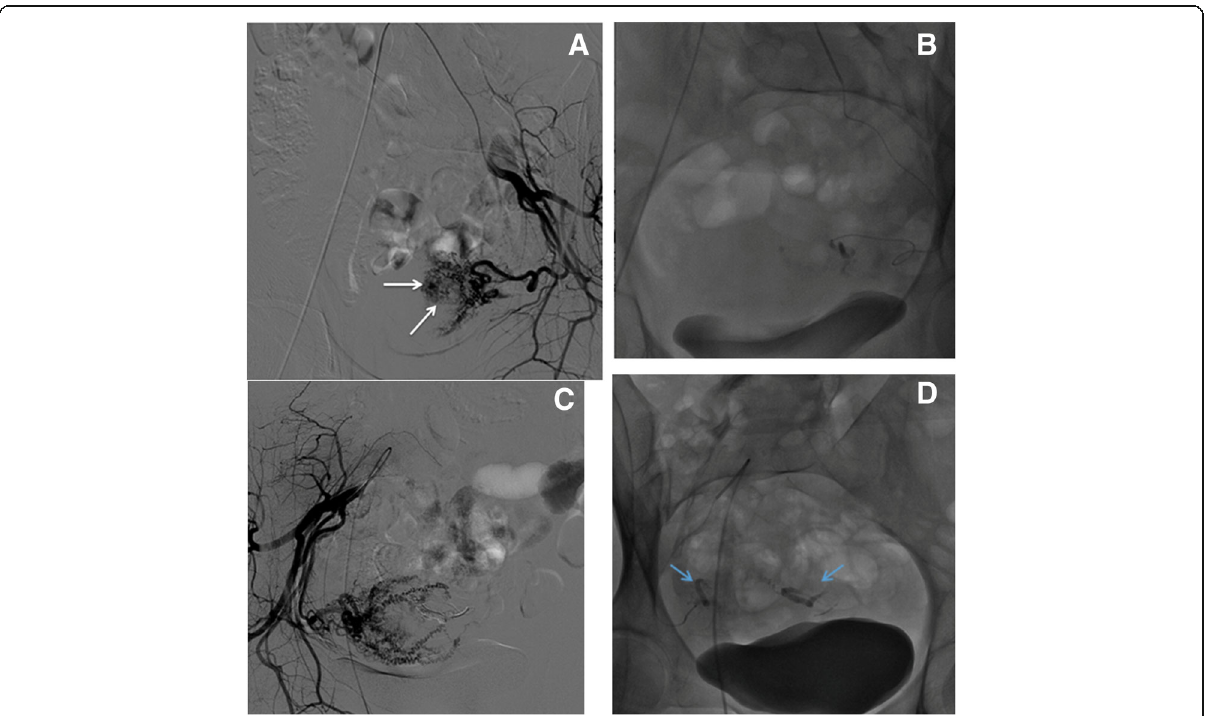
Fig. 3 Arteriovenous Malformation (AVM) embolization . a Right transfemoral DSA of the left hypogastric artery shows an uterine AVM (white arrows). b A superselective embolization with microcatheter of the left uterine artery is performed using PVA particles and Squid-18. c Diagnostic DSA of the right hypogastric artery. d After bilateral uterine AVM embolization, X-rays show both uterine arteries opacified with Squid (light blue